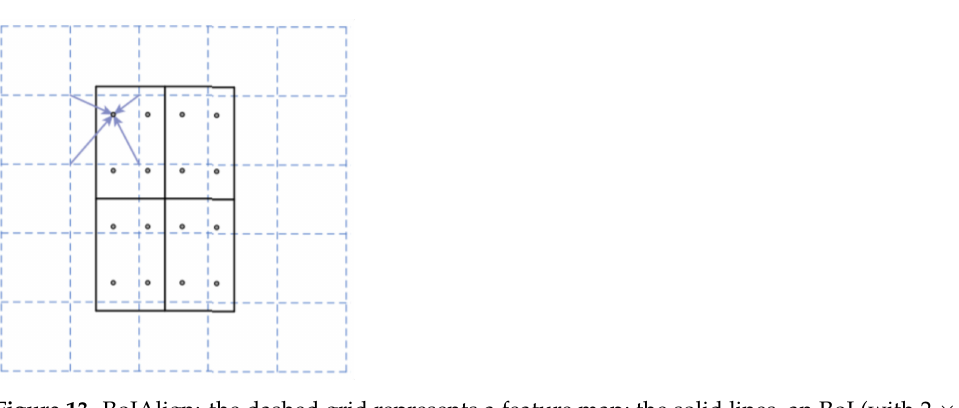
Figure 13. RoIAlign: the dashed grid represents a feature map; the solid lines, an RoI (with 2 × 2 bins in this example); and the dots, the 4 sampling points in each bin. Reprinted from ref. [10].